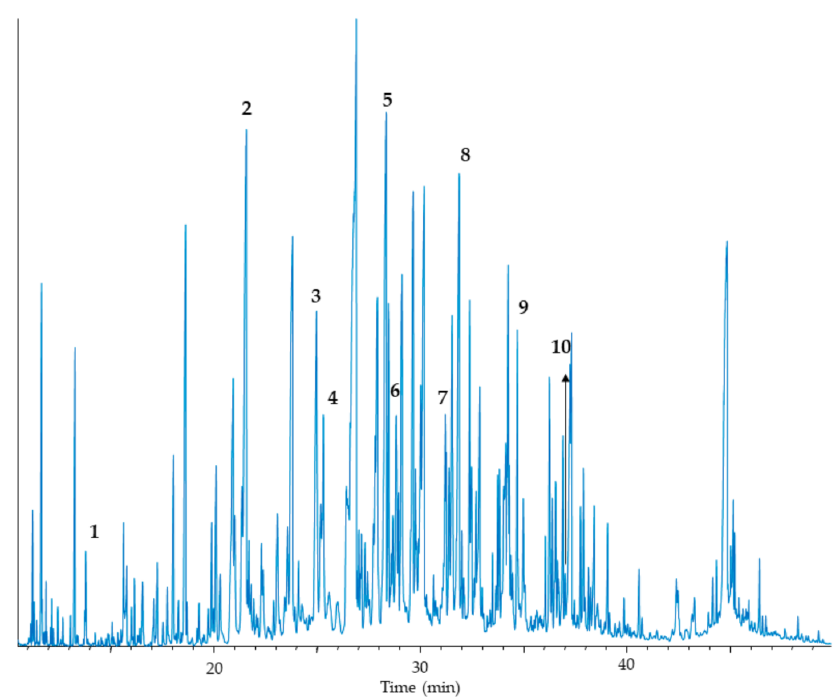
Figure 4. Urinary organic acid analysis in a VLCAD patient by GC/MS. Very slightly increased excretion of (1) 3-hydroxybutyric. Highly increased excretion of (2) adipic, (3)